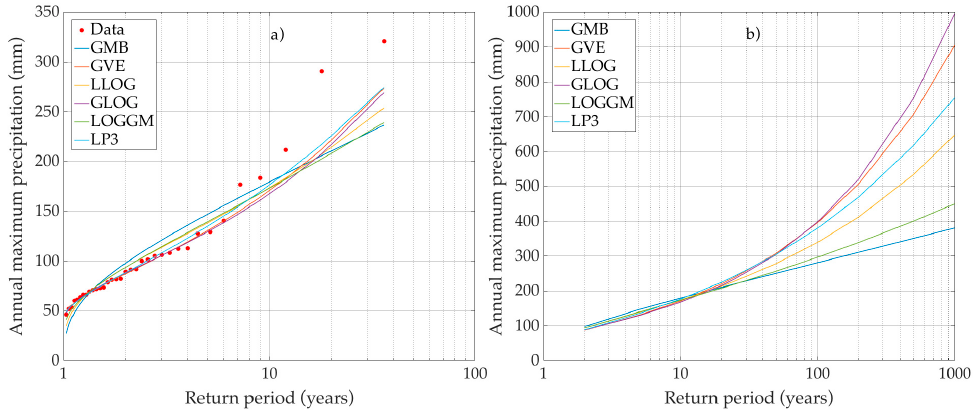
Figure 4. Frequency analysis of maximum yearly precipitation recorded at the station 6054: ( a ) fitted distributions; and ( b ) estimated quantiles. Water 2018 , 10 , x FOR PEER REVIEW